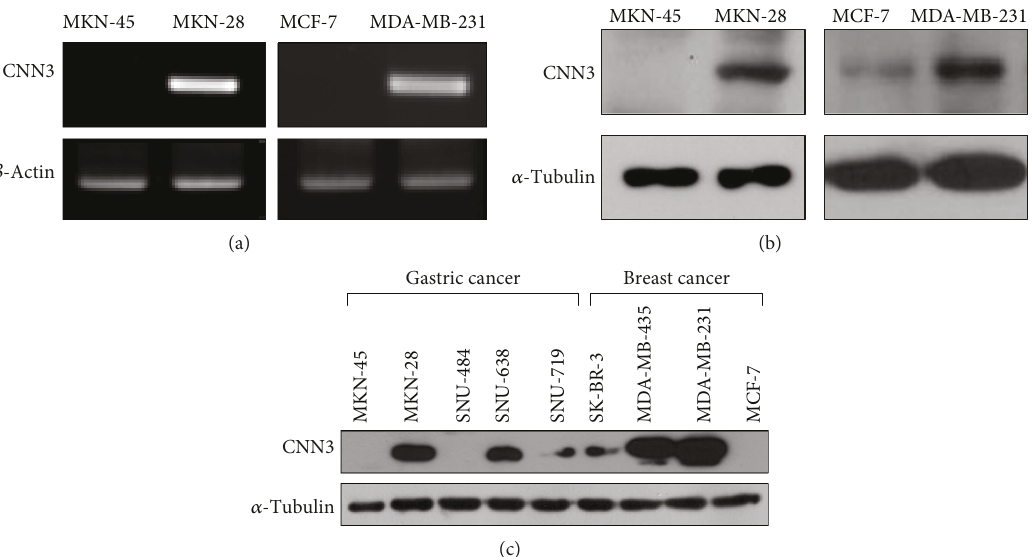
Figure 1: Correlation between CNN3 expression and cancer cell invasiveness. (a, b) RT-PCR and western blot analysis were performed to analyze the expression level of CNN3 mRNAs (a) and proteins (b) in human gastric cancer cells (MKN-45 and MKN-28) and breast cancer cells (MCF-7 and MDA-MB-231). (c) Basal expression of CNN3 in di ff erent human gastric cancer and breast cancer cell lines. Di ff erent human gastric cancer cell lines (MKN-45, MKN-28, SNU-484, SNU-638, and SNU-719) and breast cancer cell lines (SK-BR-3, MDA-MB-435, MDA-MB-231, and MCF-7) were harvested, and western blot analyses were performed to analyze the expression of CNN3 and α